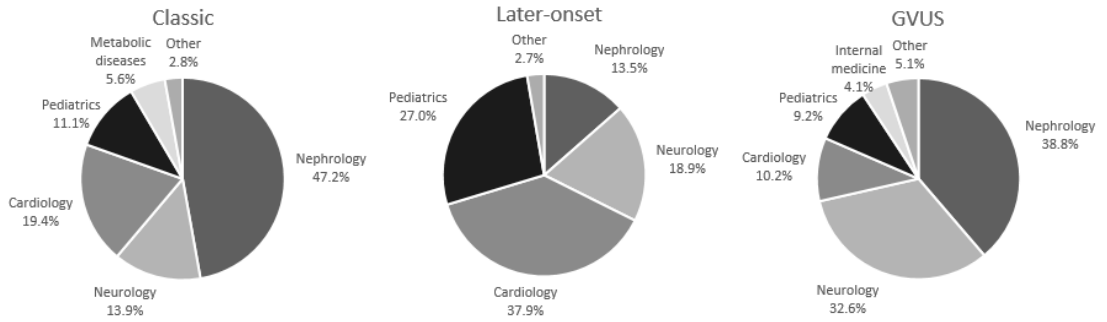
Figure 3. Clinical unit of origin of the Probands identified in our study.